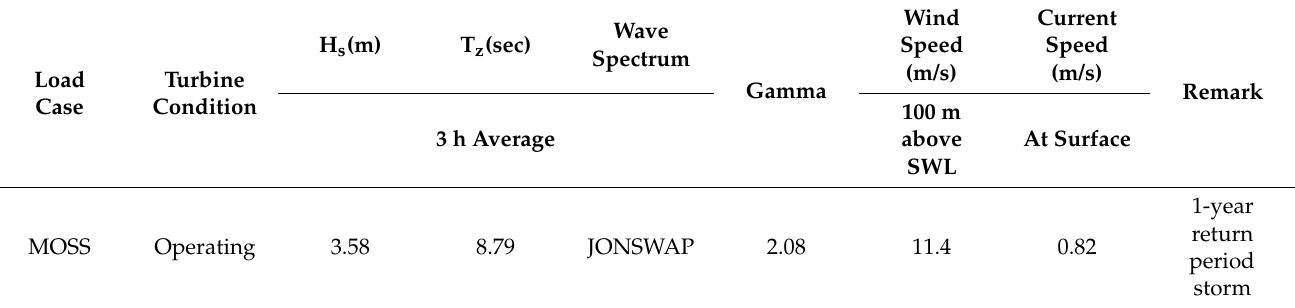
Figure 6. Directions of environmental loadings. Table 6. Marine data for MOSS (maximum operating sea state) load